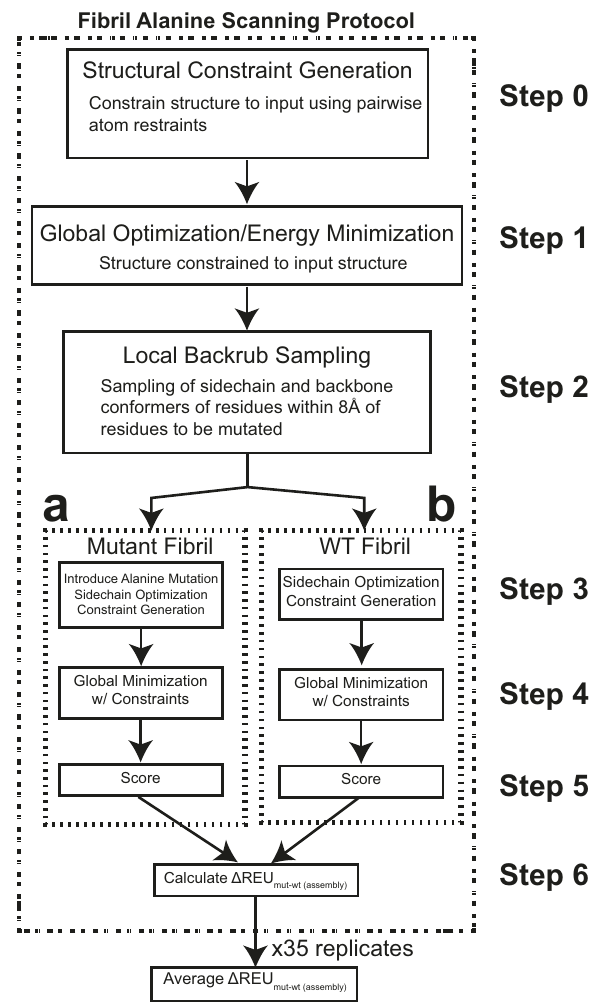
Fig. 2 | Diagram for the fi bril Flex ddG energy estimation method. Outline of fi bril fl ex Δ REU assembly fi bril is constrained to the input fi bril mut (cid:1) wt protocol. (0) The structure with atom pair constraints. (1) The input fi bril structure is minimized using harmonic restraints until convergence (absolute score change upon mini- mization of less than one Rosetta Energy Unit (REU)). (2) The backrub method 59 is used to sample additional backbone and side chain conformers proximal to the mutation site. Each backrub move is undertaken on a randomly chosen protein segment consisting of three to 12 adjacent residues with a C- β atom (C- α for gly- cines) within 8Å of the mutant positions, or adjacent residues. All atoms in the backrub segment are rotated locally about an axis de fi ned as the vector between the endpoint C- α atoms. Backrub is run at 1.2kT, for 35,000 backrub Monte Carlo steps. 35 ensemble models are generated. (3A) Alanine mutants are introduced to the backrub-sampled model, and side chain conformations for the mutant struc- ture are optimized using the Rosetta packer. (3B) alongside the alanine mutant model,awild-typemodelisalsooptimizedwiththepacker.(4A)Themutantmodel is minimized using pairwise atom-atom constraints to the input structure. Mini- mization is run with the same parameters as in step 1; the coordinate constraints usedinthissteparetakenfromthecoordinatesofthestep3Amodel.(4B)Sameas step 4A, but for the wild-type model. (5A) The model is scored both as a ‘ bound ’ protein complex and as a split, ‘ unbound ’ complex. The scores of the split, unbound complex partners are obtained simply by moving the complex halves away from each other. No further minimization or side-chain optimization is per- formed on the unbound partners before scoring. (5B) similarly to step 5A, the minimized wild-type model is scored as both in a ‘ bound ’ and ‘ unbound ’ state (6). The interface ΔΔ G and Δ REU assembly mut (cid:1) wt score using the following equations (1): 44 G interface = bound (cid:1) unbound